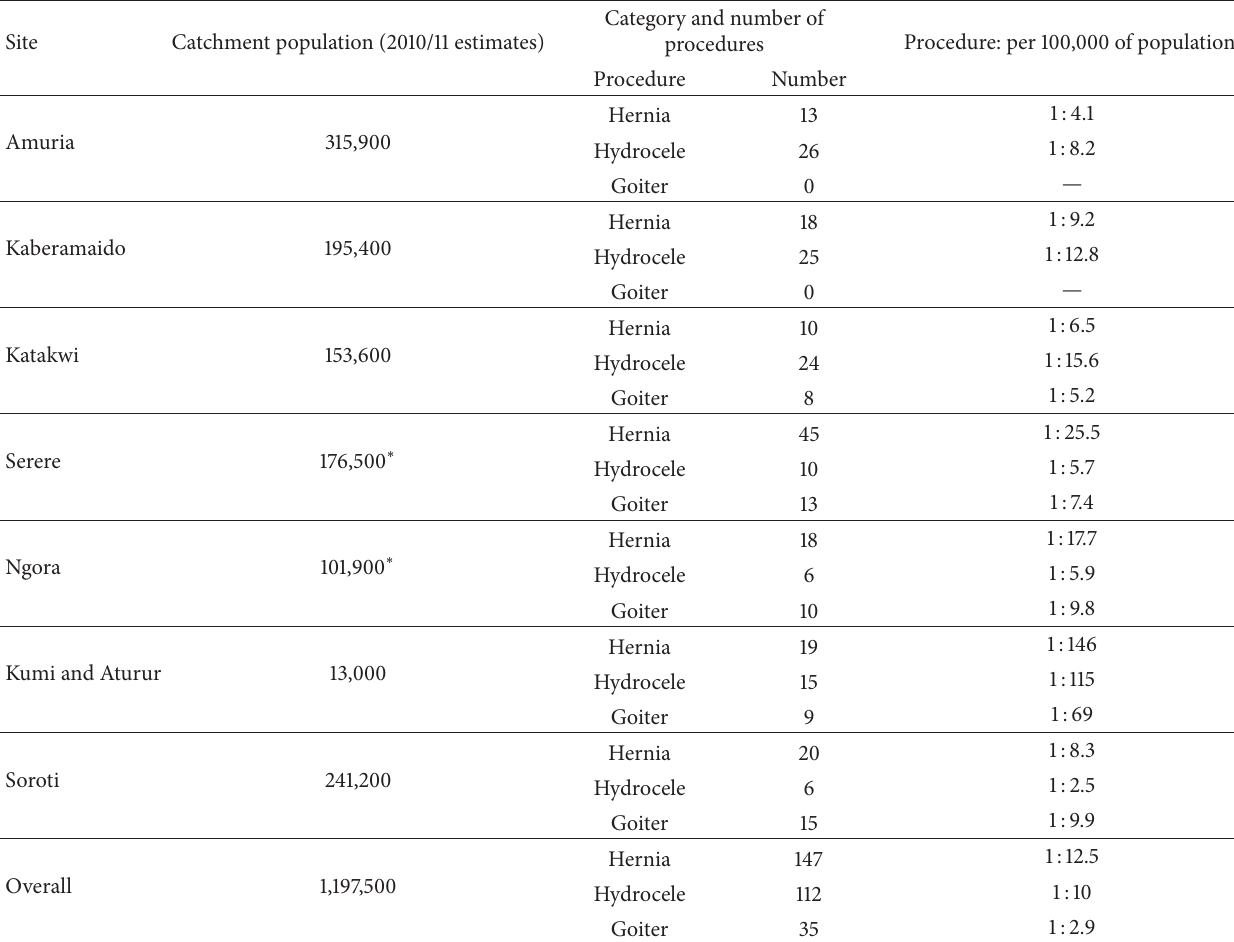
Table 3: Procedure per population rates, campsite in Uganda,